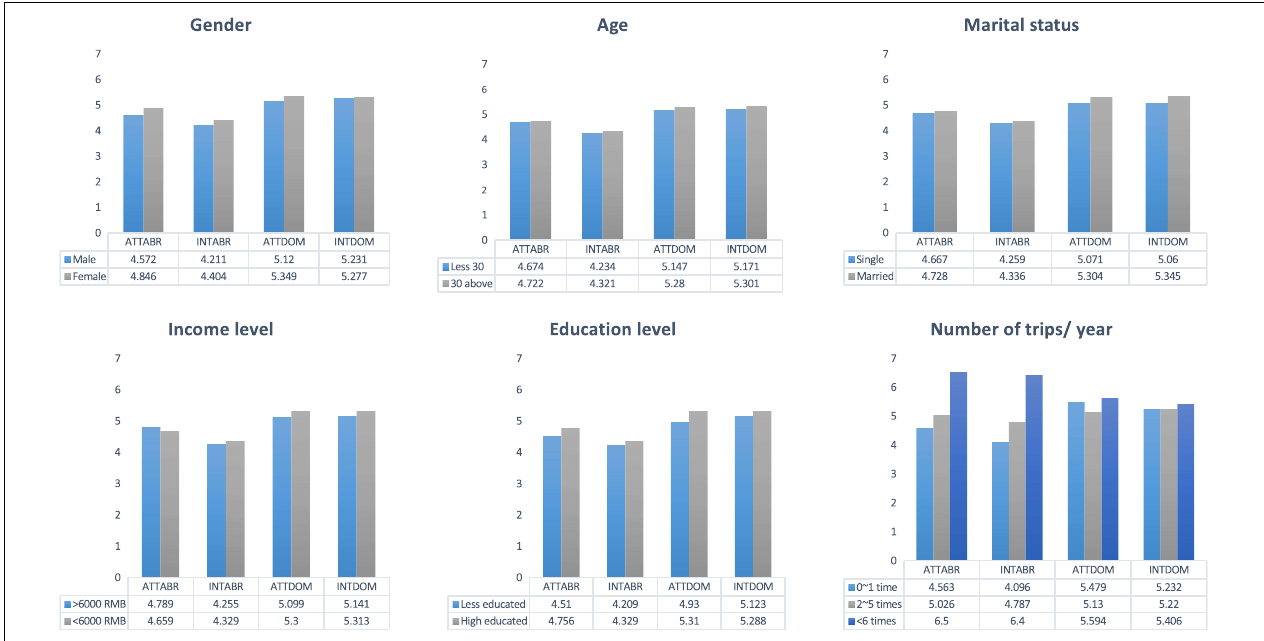
FIGURE 2 | Means comparison results by demographics.